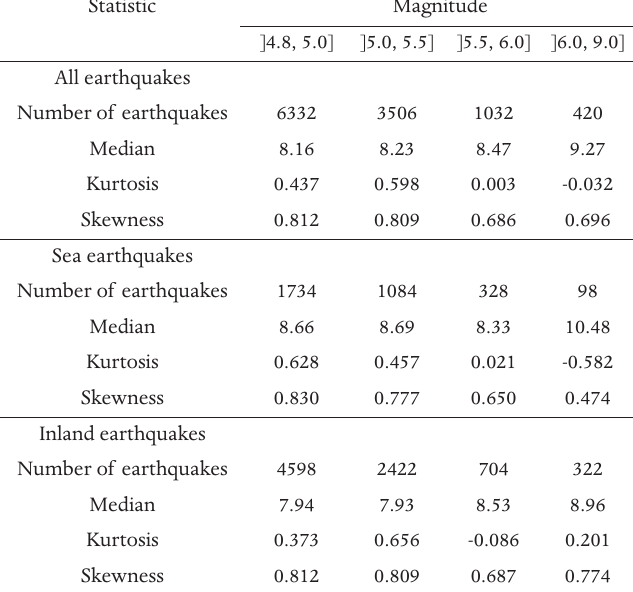
Table 2. Statistics relating to the maximum intensities A of perturbations for the earthquake database (see text for explanations). The results are given as functions of the earthquake epicentre positions and magnitudes.